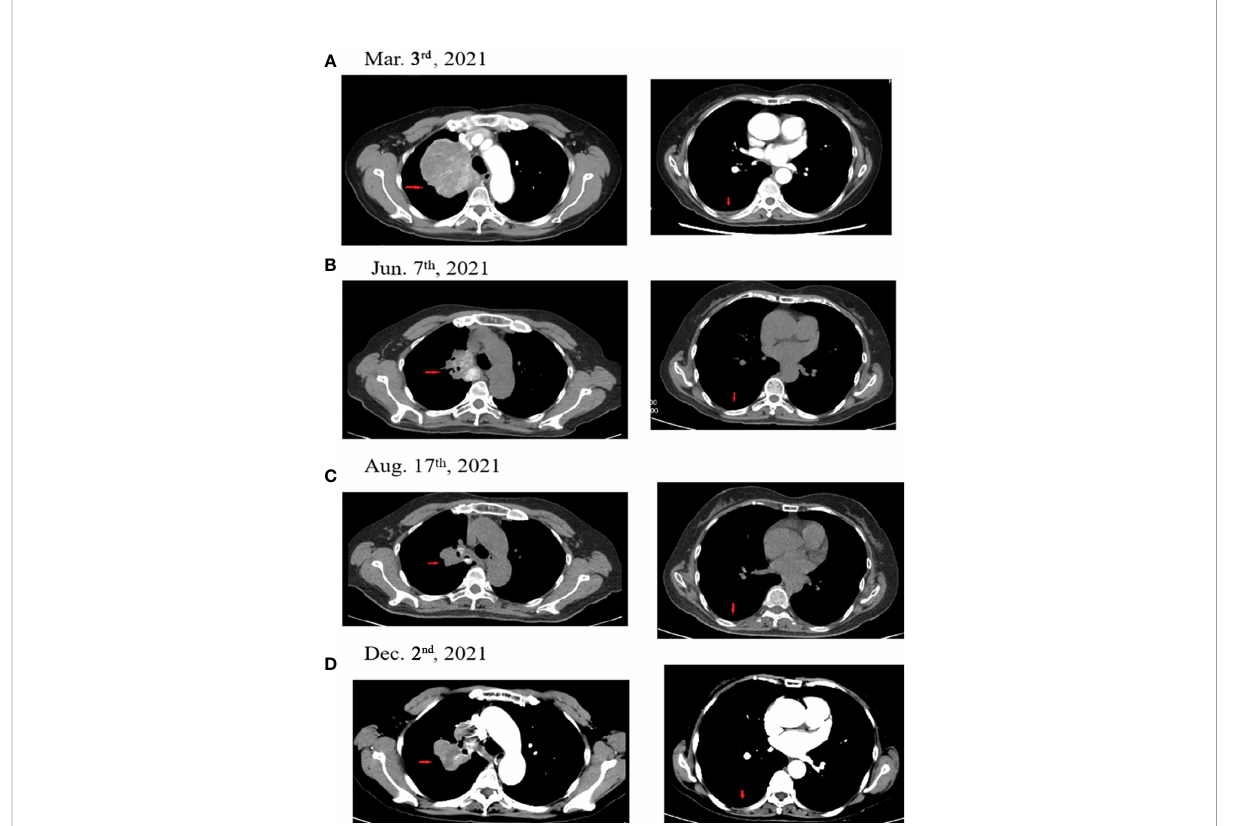
FIGURE 3 Computed tomographic (CT) images for the patient during the treatment course. (A) The patient experienced progressive disease during icotinib therapy (March 3, 2021). (B) The patient achieved PR following icotinib plus crizotinib therapy (June 7, 2021). (C) The patient achieved PR following icotinib plus crizotinib therapy (August 17, 2021). (D) The patient achieved SD following icotinib plus crizotinib therapy (December 2, 2021). Red arrows indicate the tumor.